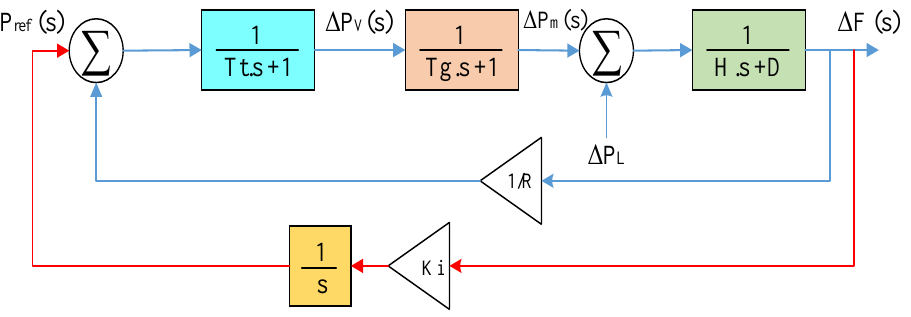
Figure 2. The LFC control block diagram of a separate system.